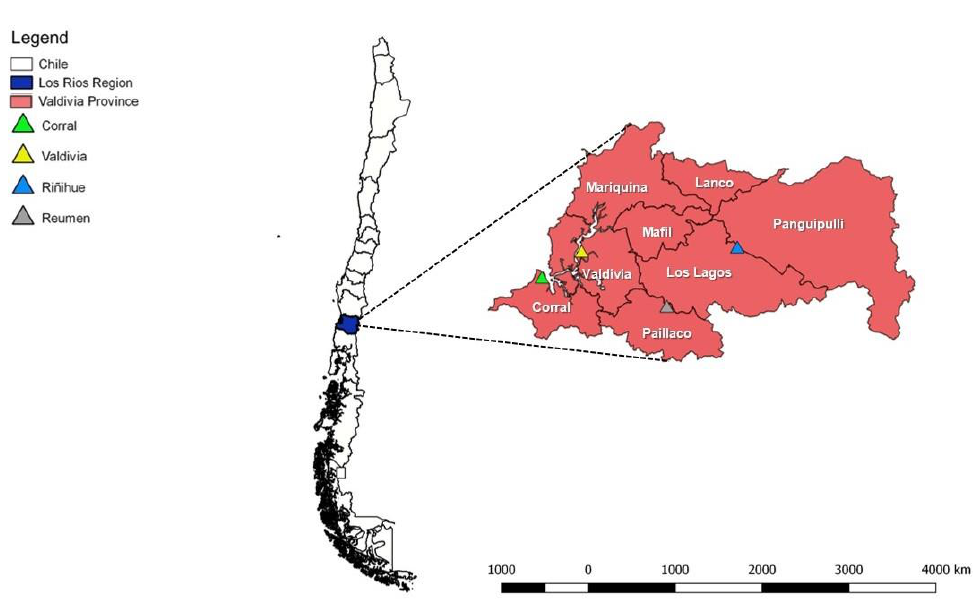
Figure 1. Dairy farms on which rodent sampling was performed, Region de Los Ríos, Valdivia, Chile. Three synanthropic species (MM , black rat (RR), and brown rat (RN)) and two wild species